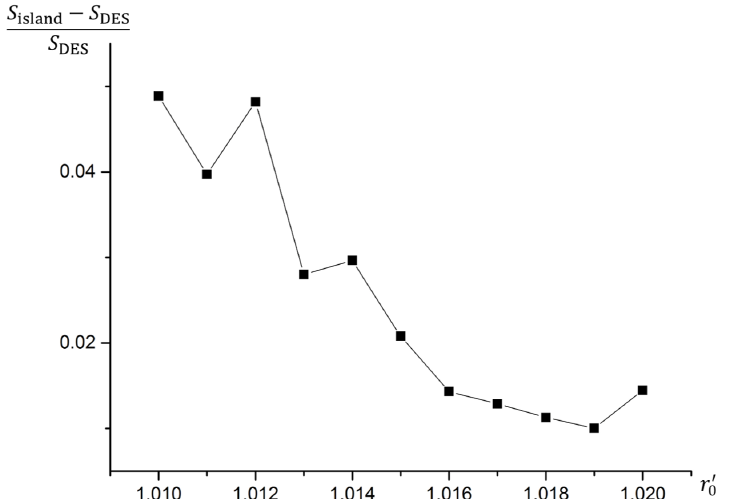
= 2 , θ = 0 . 1 and G (5) G (5) R N